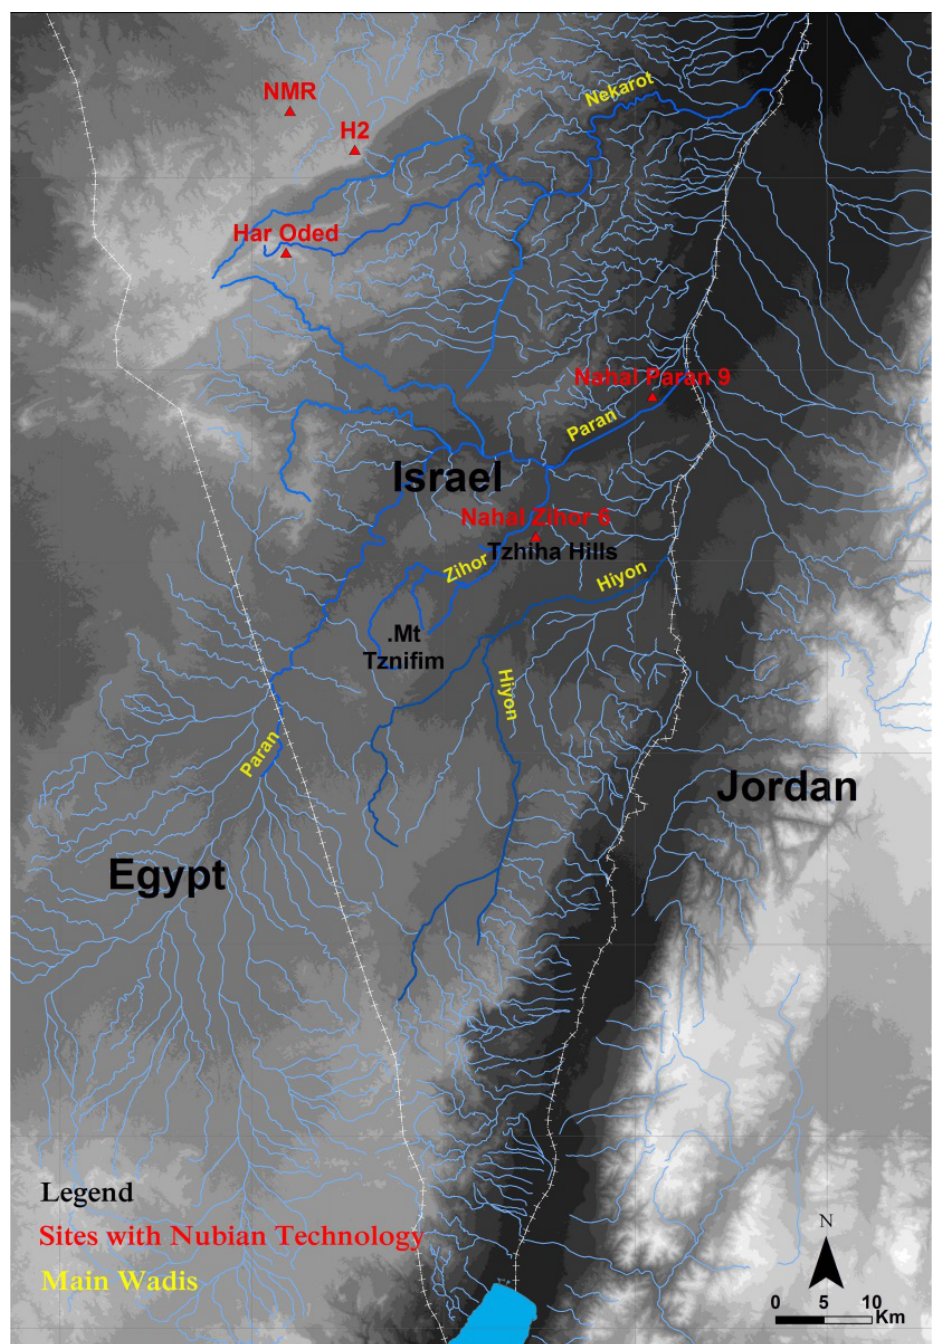
Figure 2. Map of the main wadis and their tributaries in the central Negev and Arava (marked as a rectangle on previous map). In red are Middle Paleolithic surface sites with Nubian